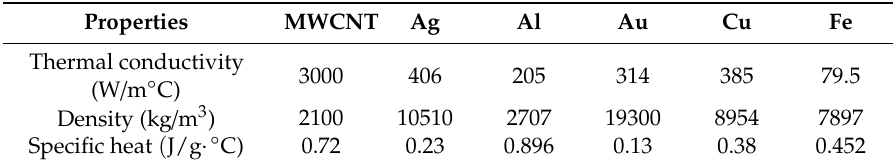
Table 1. Thermal properties of representative